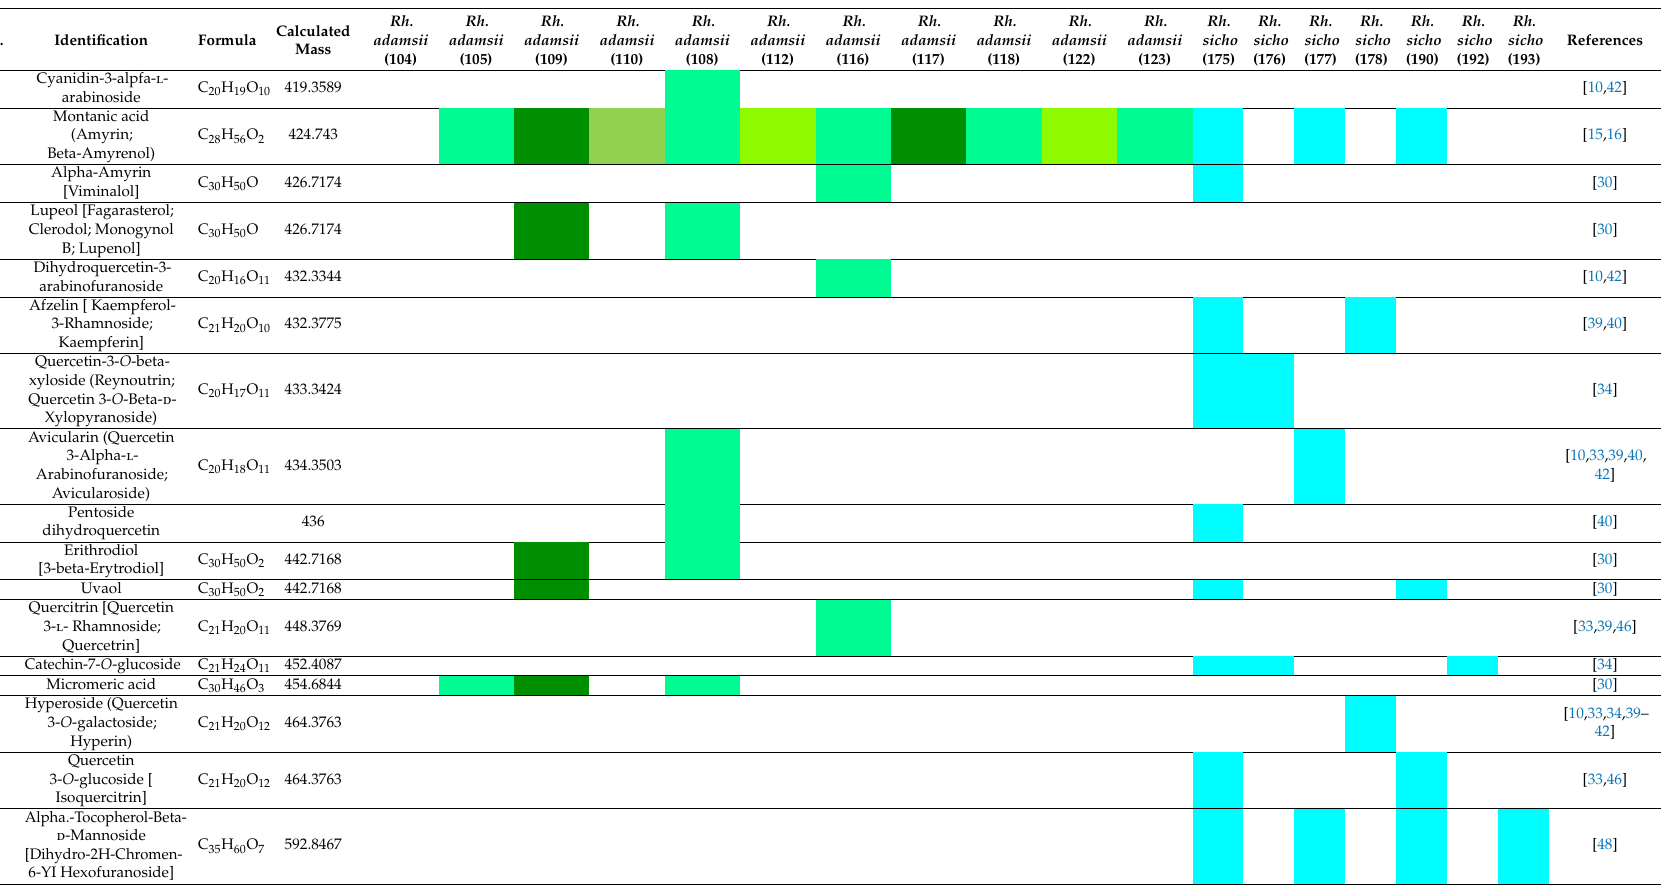
Colors are added for readability to avoid confusing columns. Green shades Rh. adamsii . blue Rh. sichotense